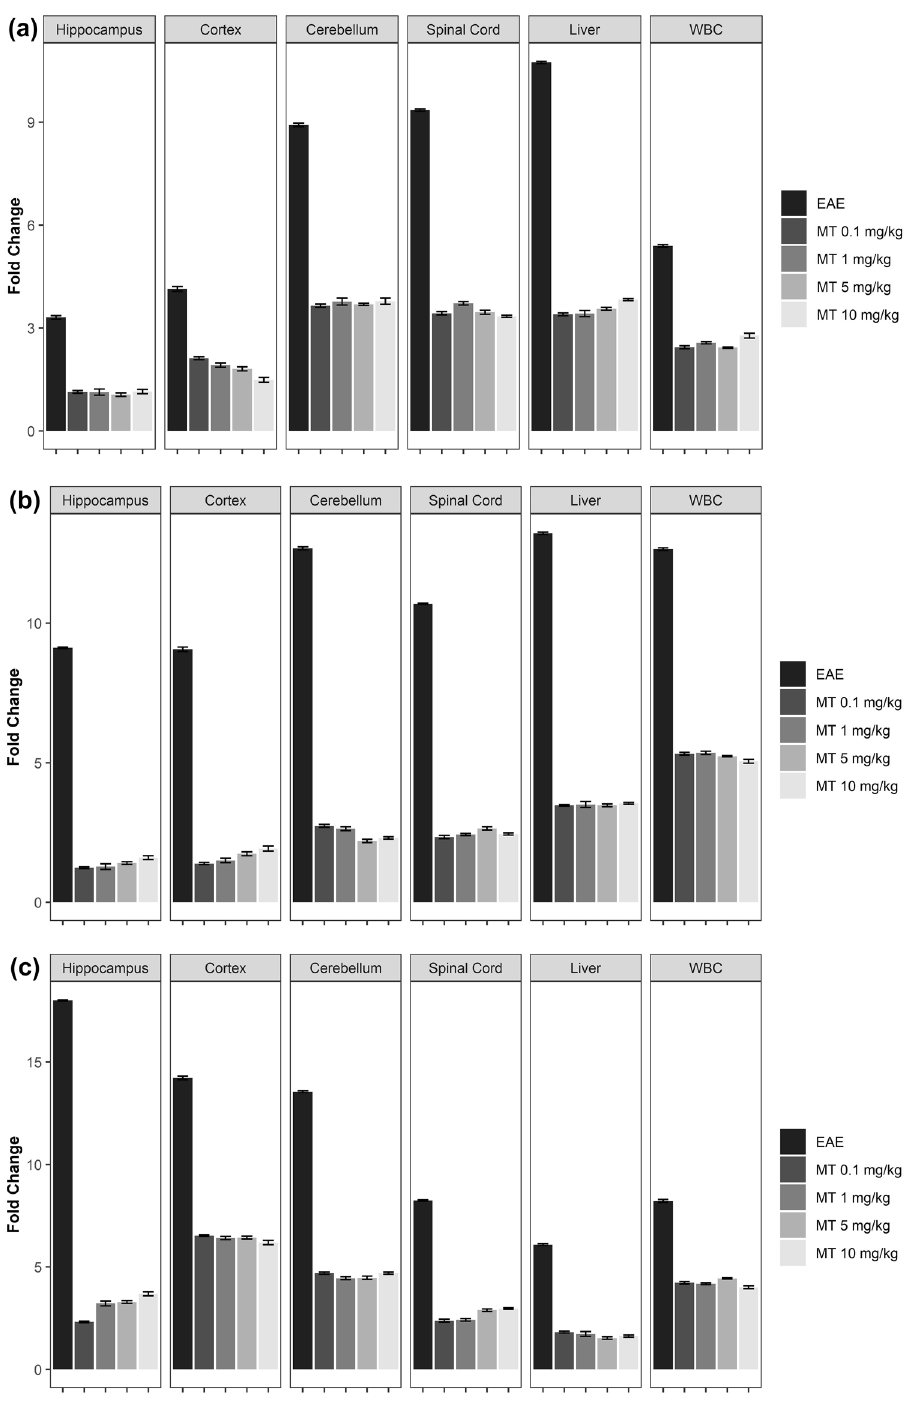
Figure 6. Effect of melatonin on mRNA expression of selected genes in different part of brain (Hippocampus, Cortex, Cerebellum), Spinal Cord, Liver and WBC. mRNA expression level of ( a ) AhR, ( b ) Interferon gamma, ( c ) Nnmt, were determined by qPCR. B2M and Eef1e1 were used as internal control. Quantification of mRNA expression levels was normalized to controls. Values are presented as a fold change compared to the control